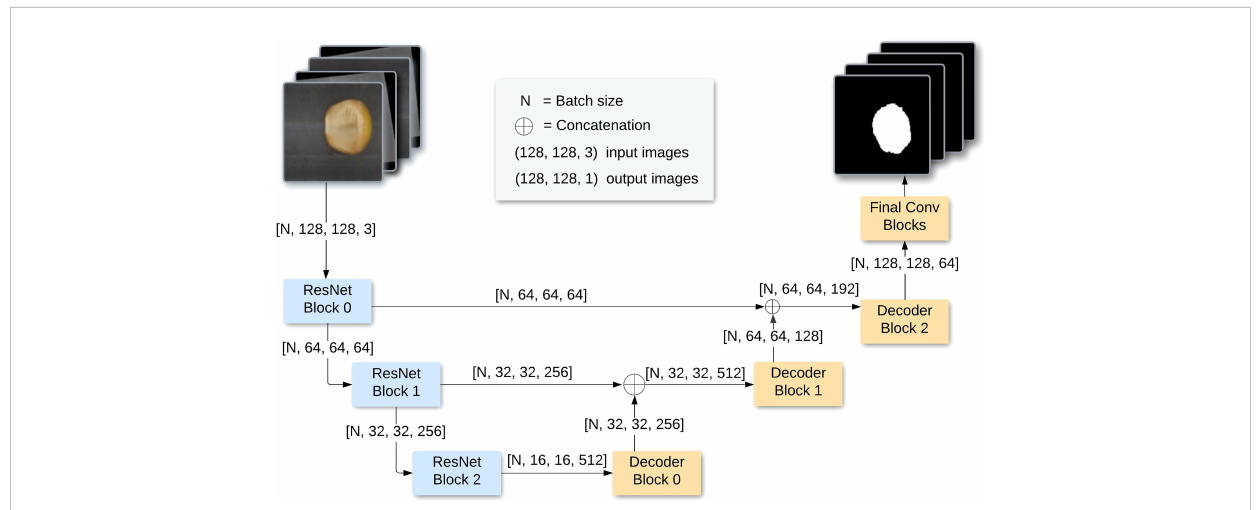
FIGURE 5 U-Net with ResNet50 backbone using fi lters of channel dimensions [64, 128, 256, 512].